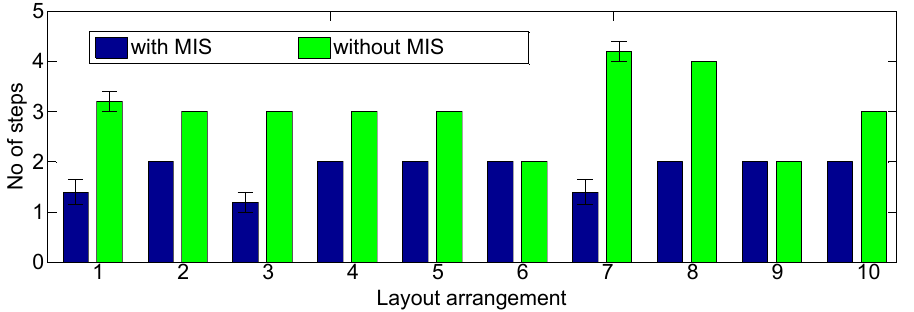
Figure 10. This graph shows the average number of steps/instructions taken in order to navigate the robot to the goal positions in different experimental layout arrangements during the experiment for evaluating the performance gain of the proposed MIS. The error bars represent the standard